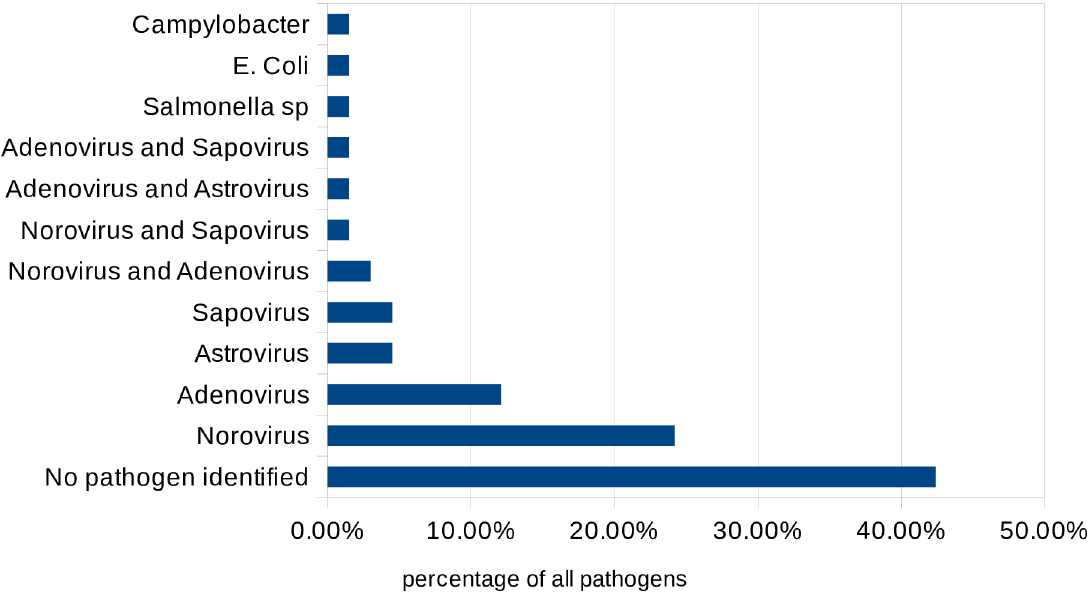
Fig 1. Diarrhoea pathogens identified in the stool sample (RNG